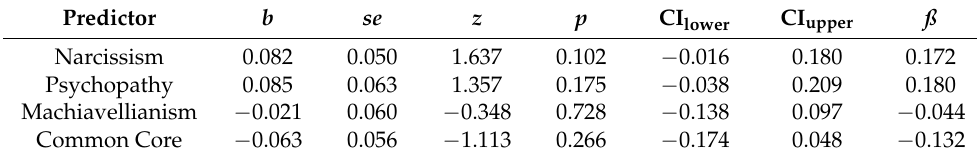
Table 4. Regression weight patterns.